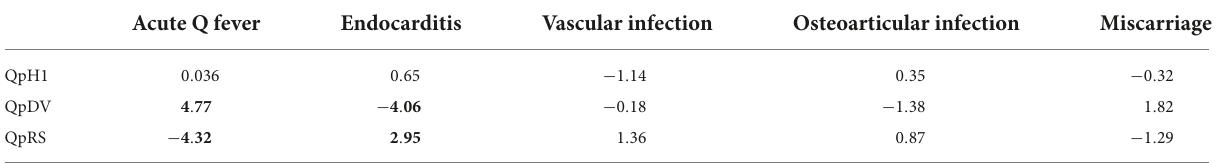
TABLE 4 Residuals